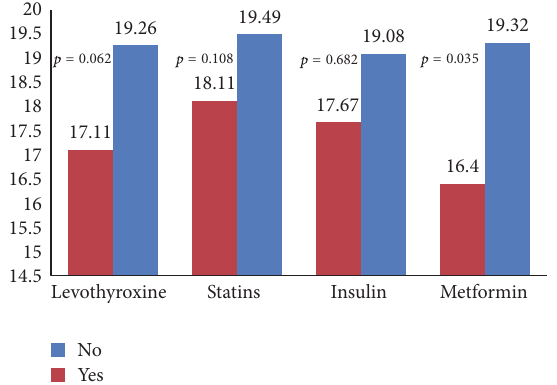
Figure 1: Oncotype DX recurrence score according to medication usage.